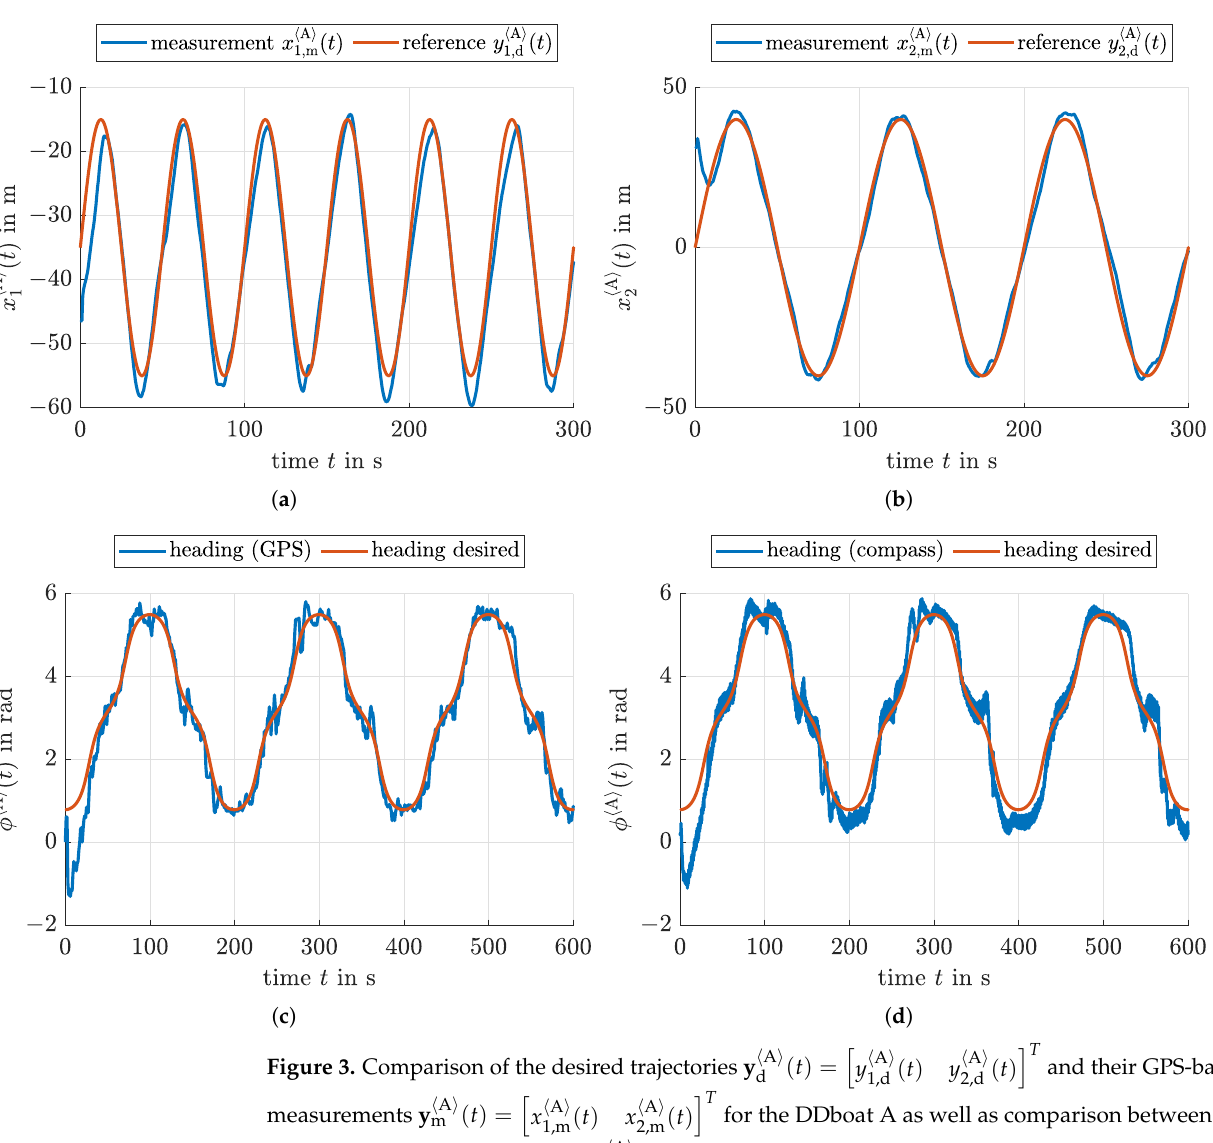
(cid:104) (cid:105) T (cid:104) A (cid:105) (cid:104) A (cid:105) ( t ) = ( t ) y (cid:104) A (cid:105) ( t ) and their GPS-based y d 1,d 2,d (cid:104) (cid:105) T (cid:104) A (cid:105) (cid:104) A (cid:105) ( t ) = ( t ) x (cid:104) A (cid:105) ( t ) for the DDboat A as well as comparison between the x m 2,m 1,m